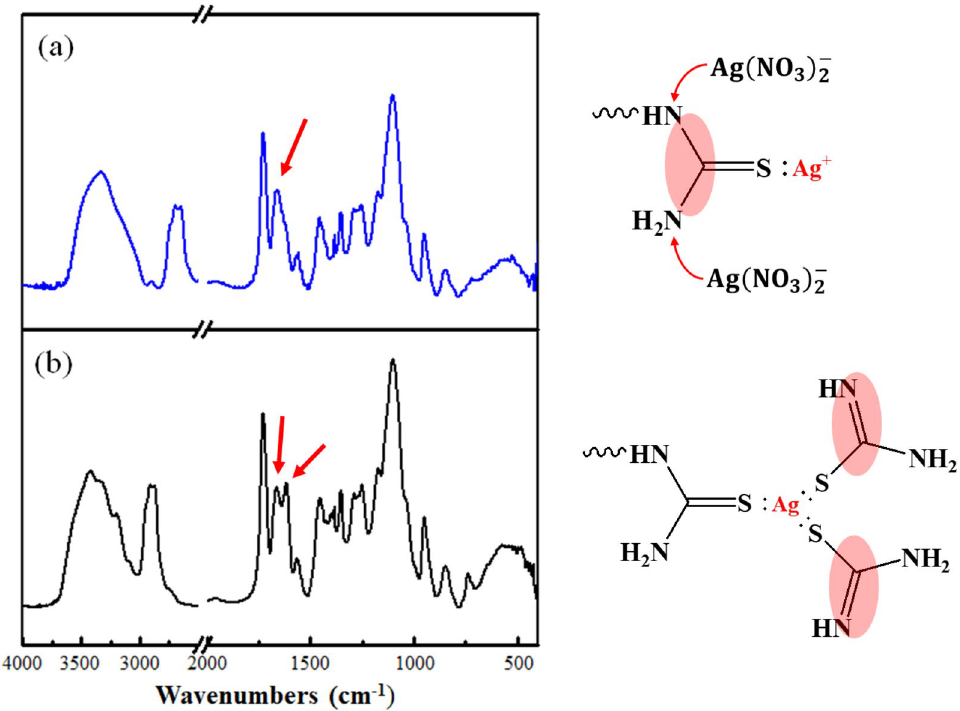
Figure 6. FTIR spectrum of ( a ) ATU-PEGDA. ( b ) Regenerated